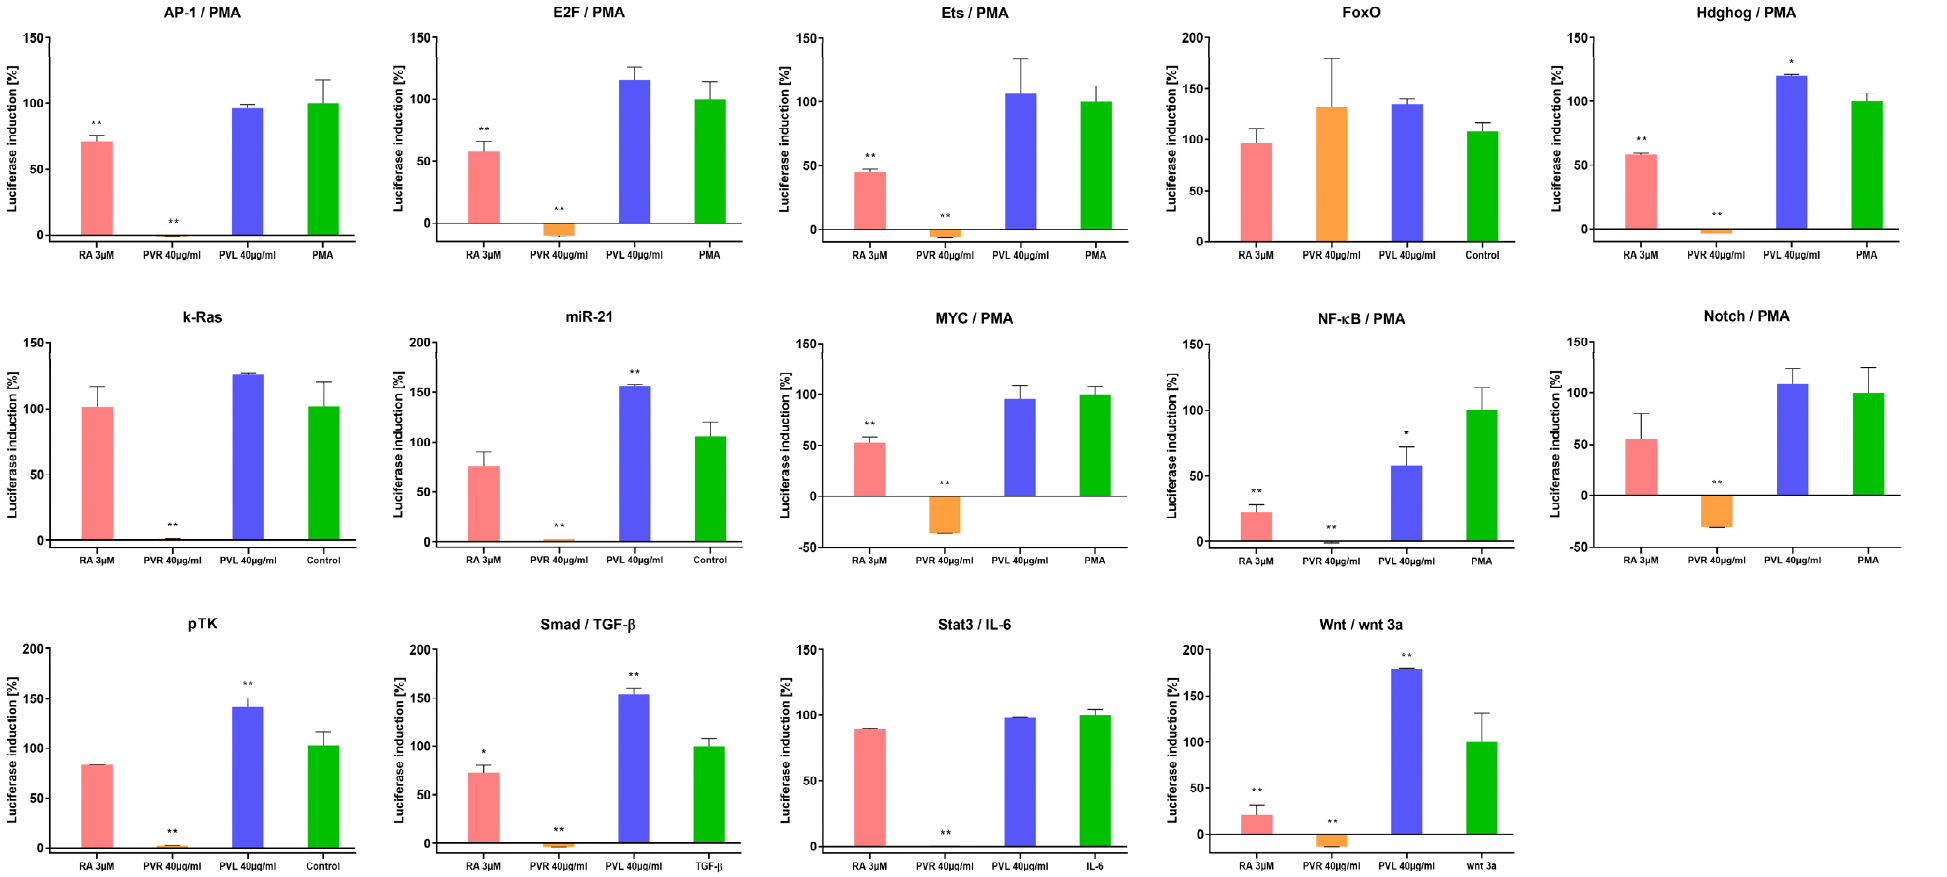
Figure 3. The inhibition of activations mainly of Notch, MYC, E2F, Wnt and NF −κ B, Ap − 1, Smad, Hdghog, Ets, Stat3 by methanolic extract of Pulsatilla vulgaris and reference/control compound—resveratrol analog. IL − 6, TGF −β , PMA, wnt 3a − Inducer (promoter) of cancer processes. Resveratrol analog (RA) − the analog 3,5,4 ′− trihydroxy − trans − stilbene, trans − resveratrol or ( E ) − resveratrol—is a stilbenoid, a type of natural phenol, and a phytoalexin with anticancer activity. PVR − Pulsatilla vulgaris root extract (40 µg/mL); PVL − Pulsatilla vulgaris leaves extract (40 µg/mL); PMA − Phorbol 12 − myristate 13 − acetate; TGF − ß − Transforming growth factor beta; IL − 6 ‒ Interleukin 6; wnt 3a − Wnt family member 3A. The obtained data were statistically analyzed using GraphPad Prism (two − way ANOVA, Dunnett’s multiple comparisons test), where * p < 0.05; ** p < 0.01.